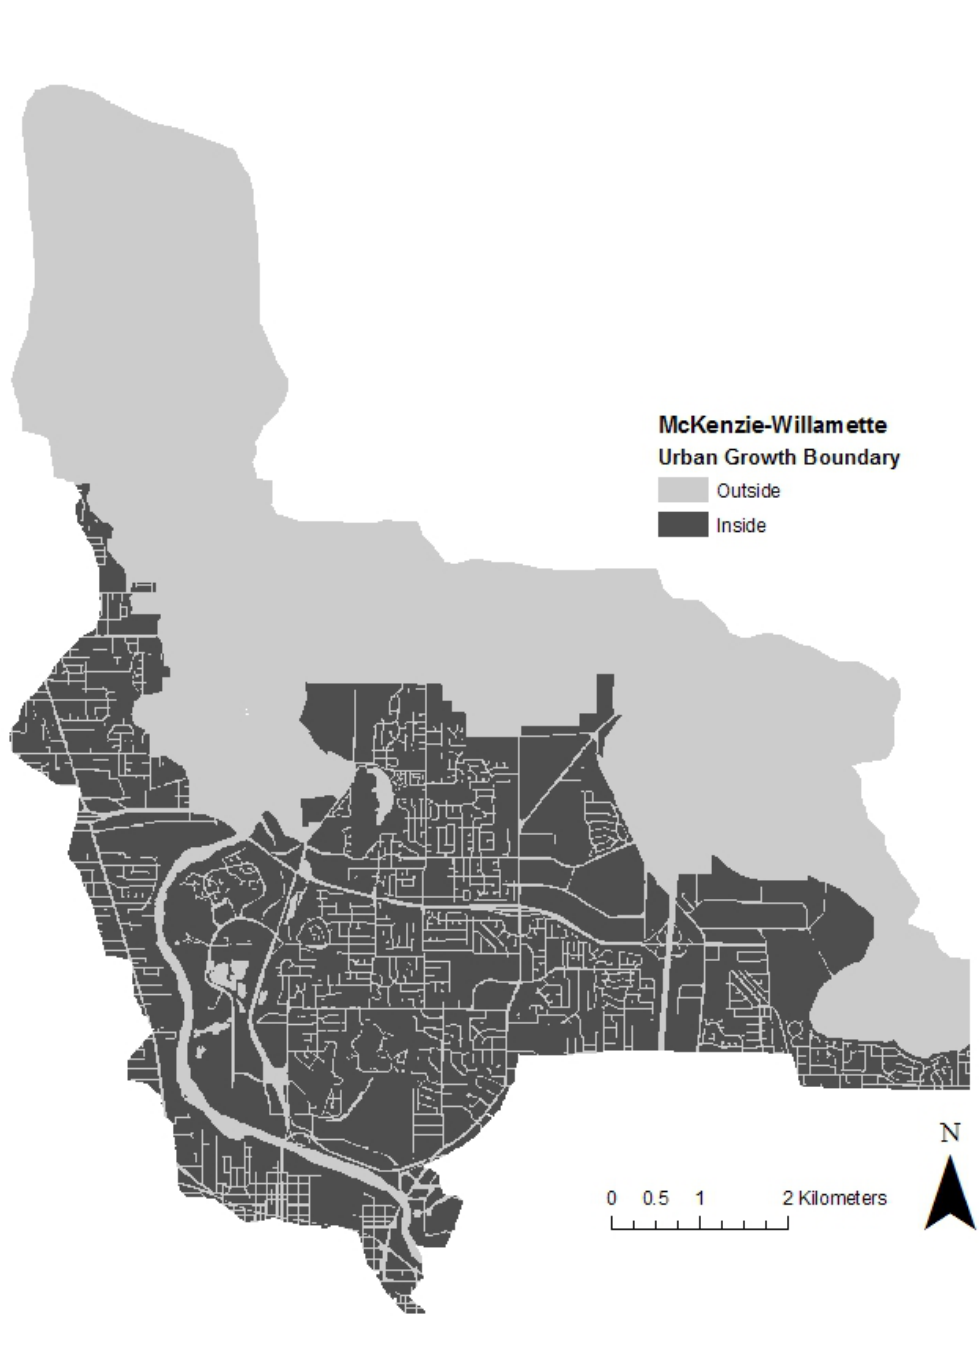
Fig. 6 . Crossing the center of the study area is the urban growth boundary. The urbanization area is dark